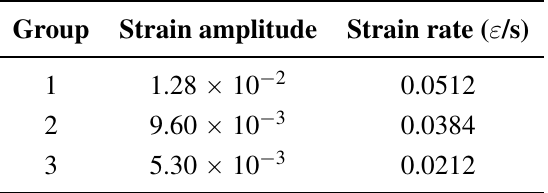
Table 5. Strain rate estimates in the HDPE fatigue